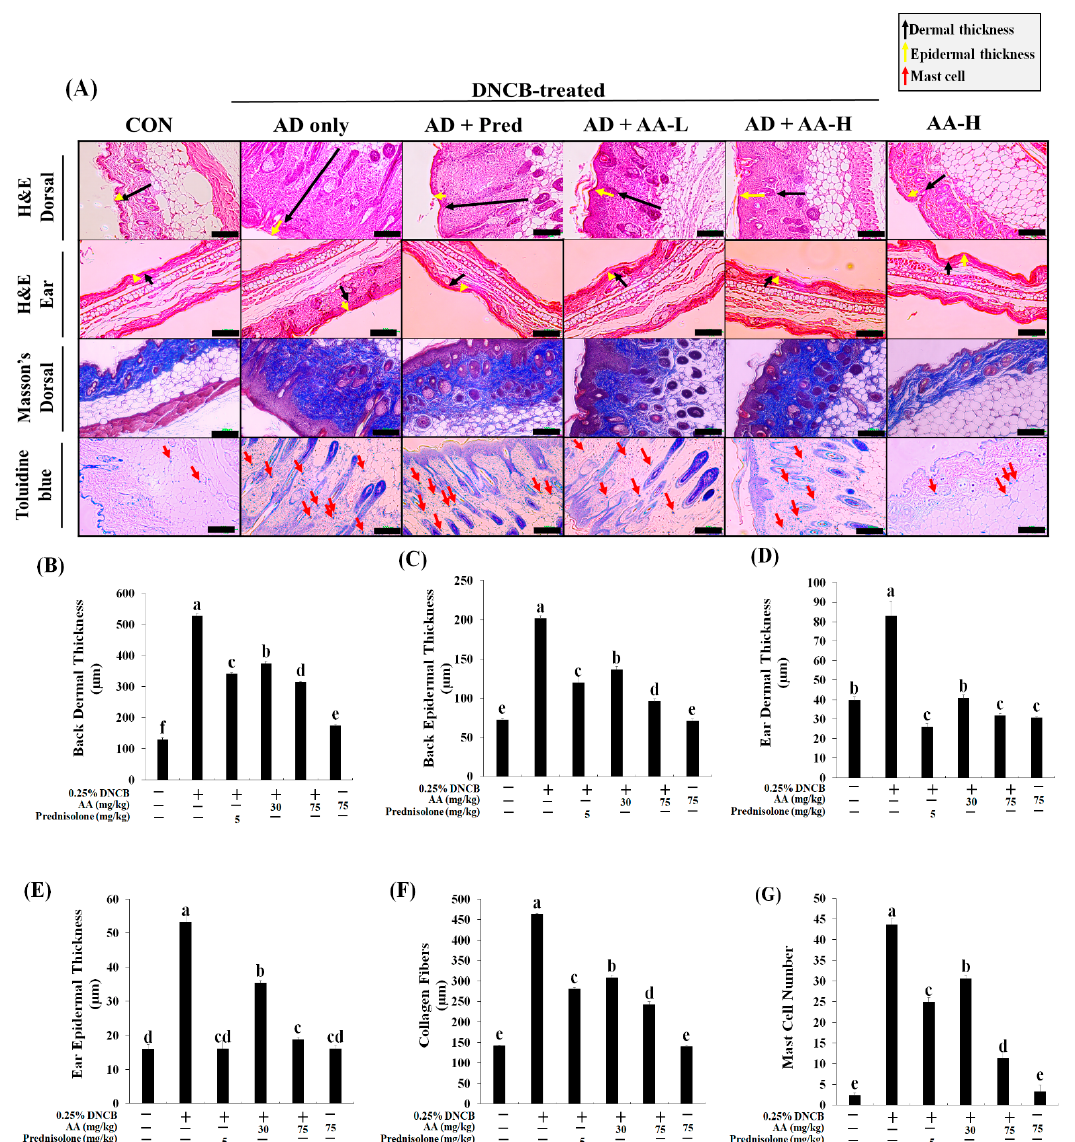
Figure 5. Effects of asiatic acid (AA) on dermal and epidermal thickness, collagen fibers, and mast cell infiltration were assessed histologically. ( A ) Atopic dermatitis (AD) skin lesions were stained using hematoxylin and eosin (H&E), Masson’s trichrome, or toluidine blue, and were photographed under a light microscope at 100× magnification (scale bar: 100 µm). ( B – E ) The dermal and epidermal thicknesses were evaluated using H&E-stained dorsal and ear tissue microphoto- graphs. ( F ) Collagen fibers were evaluated using Masson’s trichrome staining. ( G ) Mast cells were counted after toluidine blue staining; the blue points denote mast cells. Values were significant according to Duncan’s multiple range test ( p < 0.05), and the values are represented as the mean ± standard deviation ( n = 7 per group). The significant values are repre- sented by different letters (p < 0.05 ). CON, control group; AD only, mice sensitized with 0.25% 2,4-dinitrochlorobenzene (DNCB) in 200 µL of 3:1 acetone/bean oil; AD + AA-L and AD + AA-H, 30 and 75 mg/kg AA-treated DNCB-sensitized mice, respectively, in 100 µL of sterilized drinking water; AA-H, mice orally administered 75 mg/kg AA; AD + Pred, positive control mice treated with 5 mg/kg prednisolone in 100 µL of sterilized drinking water.